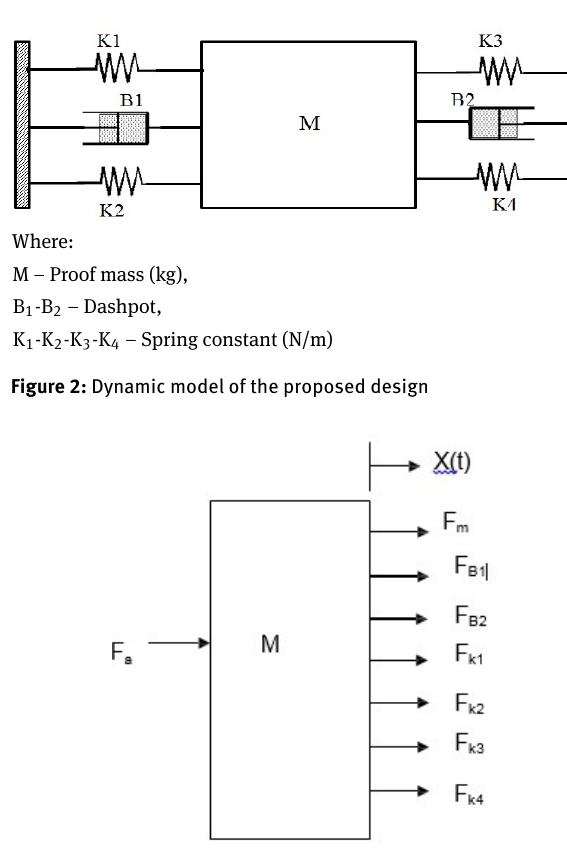
Figure 3: Free body